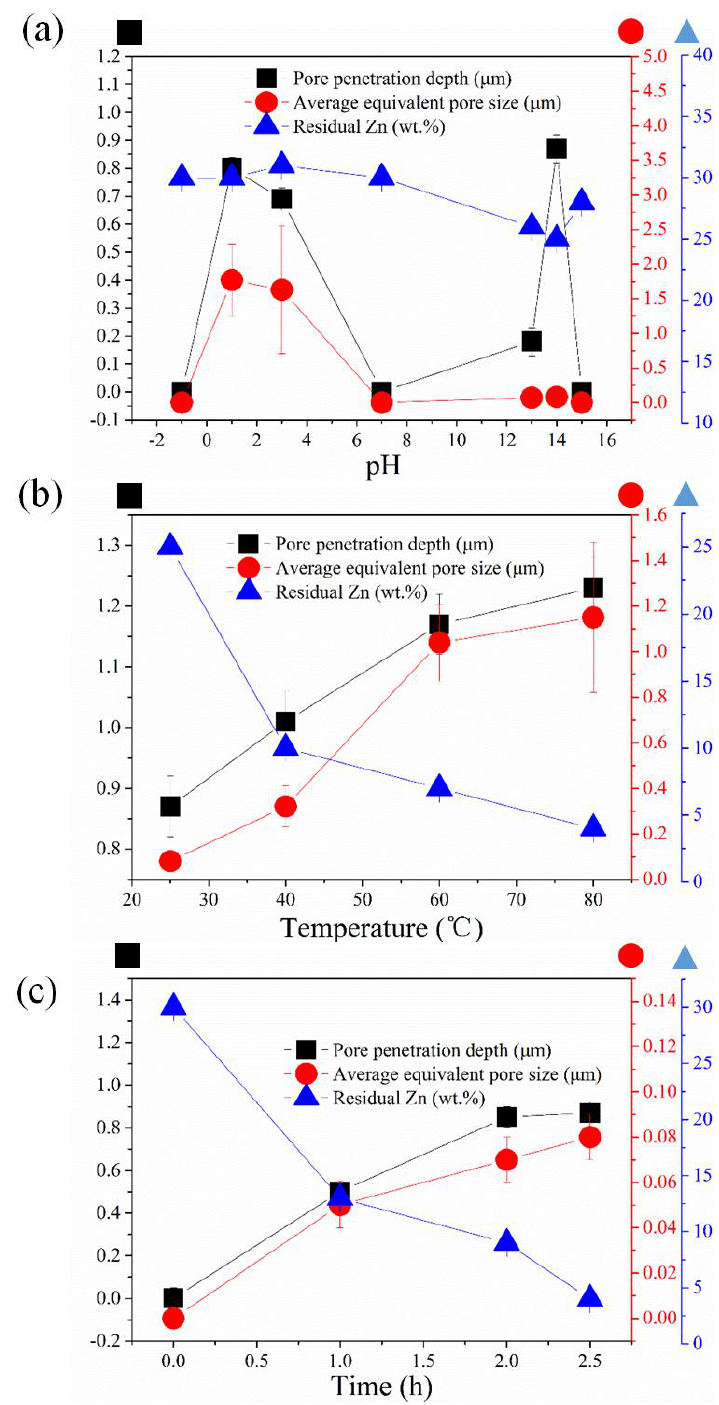
content from energy dispersive spectroscopy (EDS): ( a ) pH value-based series de-alloyed foil de-alloyed with different etching solutions (10 M HCl (pH = −1), 1 M HCl (pH = 1), 0.01 M HCl (pH = 3), 10 M NaOH (pH = 15), 1 M NaOH (pH = 14) and 0.1 M NaOH (pH = 13)) for 2.5 h at 25 °C; ( b ) temperature-based series de-alloyed foil de-alloyed with 1 M NaOH for 2.5 h; and ( c ) time-based series de-alloyed foil de-alloyed with 1 M NaOH at 60